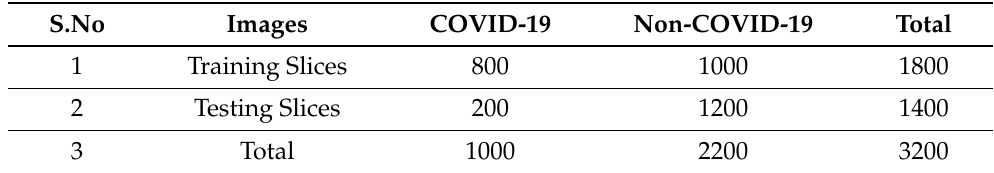
Table 1. Description of data set used for